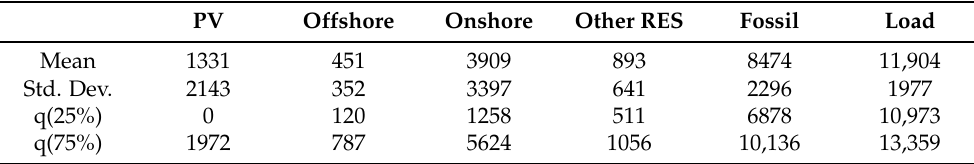
Table 1. Actual hourly measurement data in MW from 1 October 2018 to 31 December 2021. PV Offshore Other RES Fossil